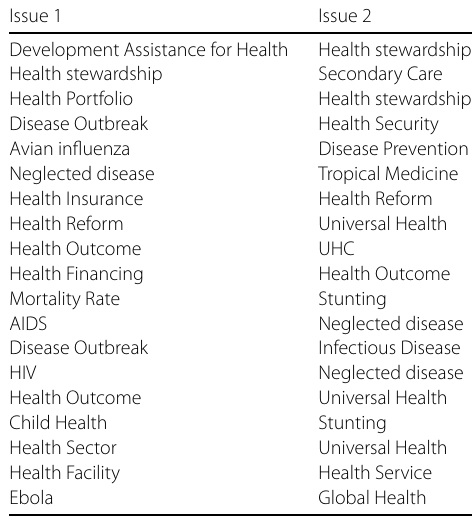
Table A4 The 19 connections in the issue–issue network that are not significantly connected in any of the crawled websites, but are significantly related in the aid community as a